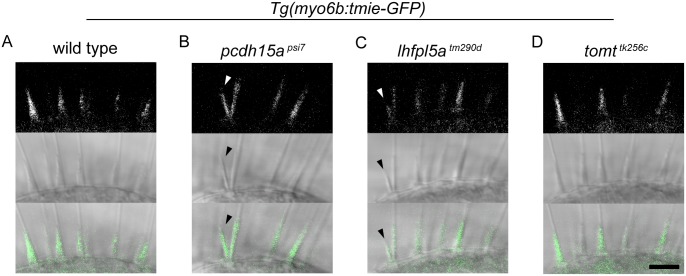
Tmie-GFP is present in the hair bundles of MET mutants.Confocal images of the bundle region in hair cells of the inner ear lateral cristae in 6 dpf larvae. Larvae expressing transgenic Tmie-GFP in the genetic backgrounds of wild type (A), and homozygous mutants for the tip link protein Pcdh15a (B, pcdh15apsi7), the accessory protein Lhfpl5a (C, lhfpl5atm290d), and the Golgi-localized protein Tomt (D, tomttk256c). Tomt-deficient fish lack Tmc expression in hair cell bundles [11], presumably mimicking the condition of a triple Tmc knockout. Arrowheads indicate splayed hair bundles. n = 8 each genotype. Scale bar is 5μm.